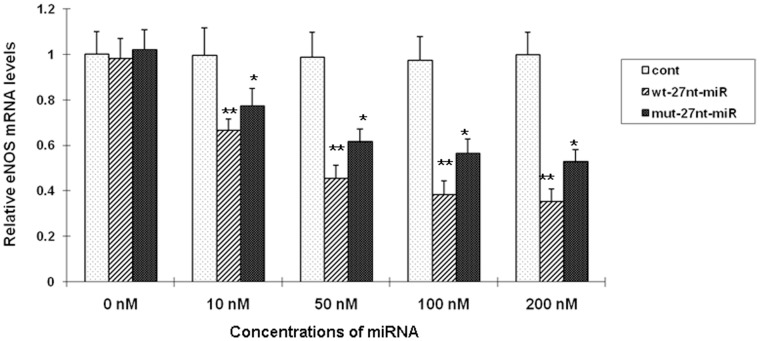
Effect of miRNAs on eNOS transcription efficiency in vitro.The nuclei of HAECs were isolated and prepared for the nuclear run-on transcription reaction to determine the eNOS transcription efficiency (the relative mRNA levels of eNOS and β-actin) in the presence of different miRNAs with RT-PCR. The concentrations of the miRNA oligonucleotides, wt-27nt-miRNA or mut-27nt-miRNA, are 0, 10, 50, 100, or 200 nM. Cont, cells transfected with control plasmid; wt-27nt-miR: cells transfected with plasmid expressing wild-ytpe 27-nt-miRNA; mut-27nt-miR: cells transfected with plasmid expressing mutant 27-nt-miRNA. *, P<0.05; **, P<0.01 vs control (n = 3).